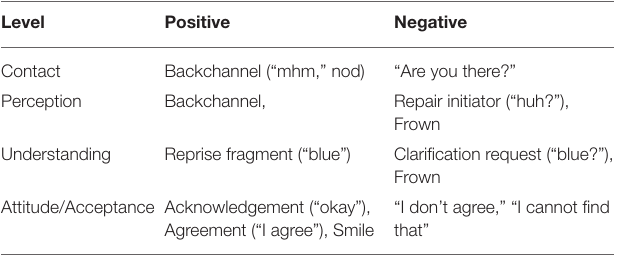
TABLE 1 | Examples of positive and negative feedback on different levels and across different modalities (e.g., speech, facial expression, head gesture). Level Positive Negative Contact Backchannel (“mhm,” nod) “Are you there?” Perception